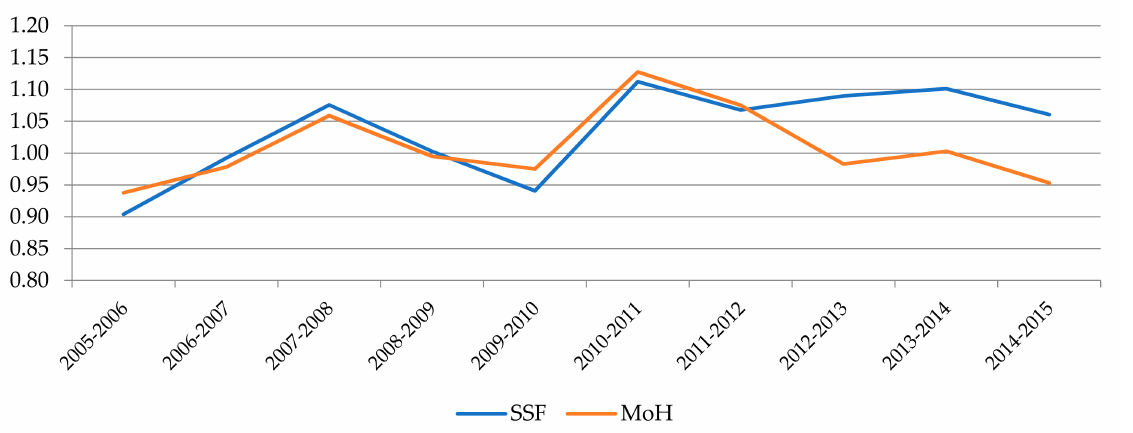
Figure 4. Evolution of TC by type of